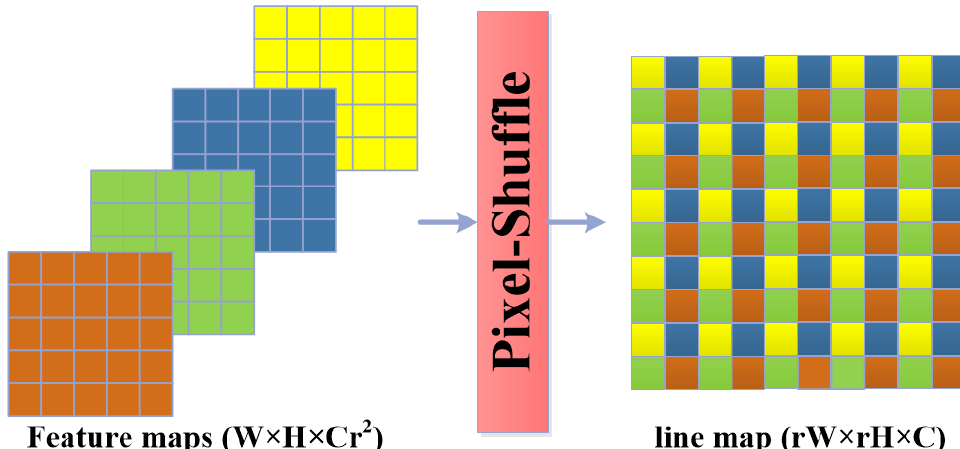
Figure 3. Pixel-shuffle: the pixels are mapped from the small-scale feature maps of size ( W × H × Cr 2 ) to form super pixels in the large-scale line map of the size ( rW × rH × C